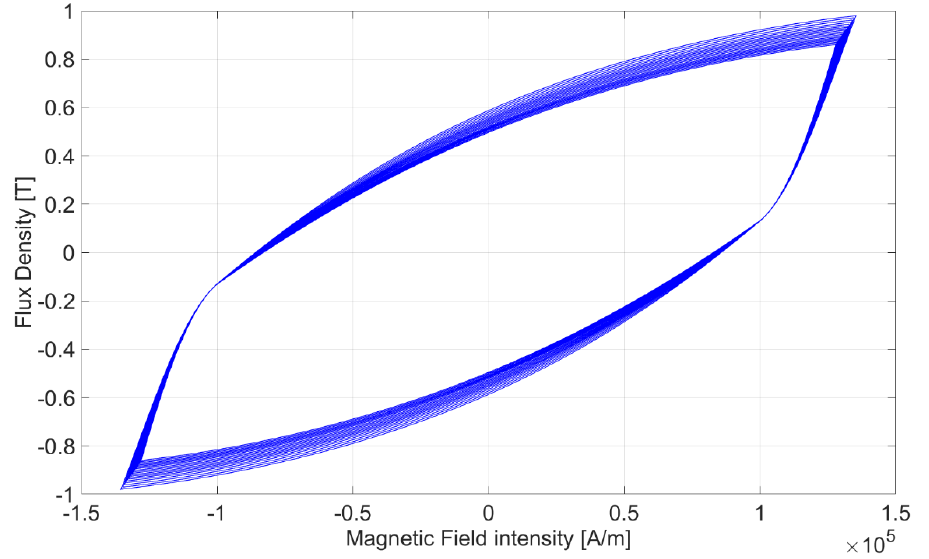
Figure 10. Radial hysteresis loops in the hysteresis region.